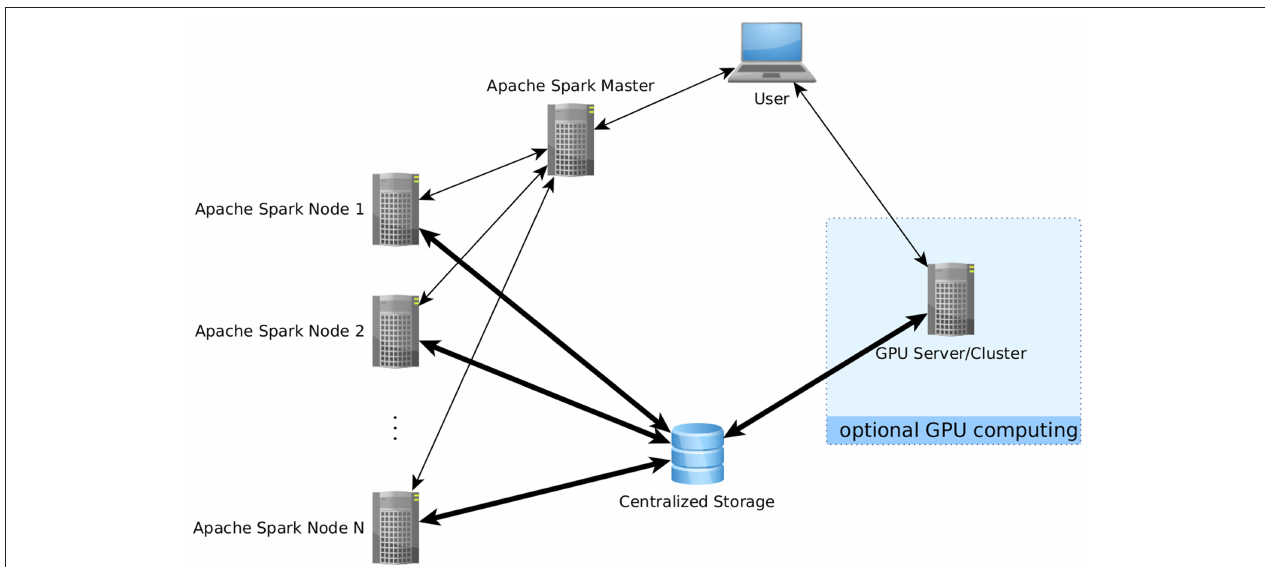
FIGURE 1 | Data flow using the proposed analysis methods. Bold arrows represent intensive data flow, the other arrows represent communication of control commands. In this example, parts of the computations have been performed on a separate GPU computing server which was not part of the Apache Spark cluster. The use of a centralized data storage facilitates the integration of all steps into a comprehensive pipeline, as the fMRI data is loaded directly from there onto the GPU server, who then writes the results as edgelist back on the storage to be directly readable by Apache Spark. Note that storing data directly on the compute nodes is also possible as an alternative if issues related to data transfer speed are encountered.